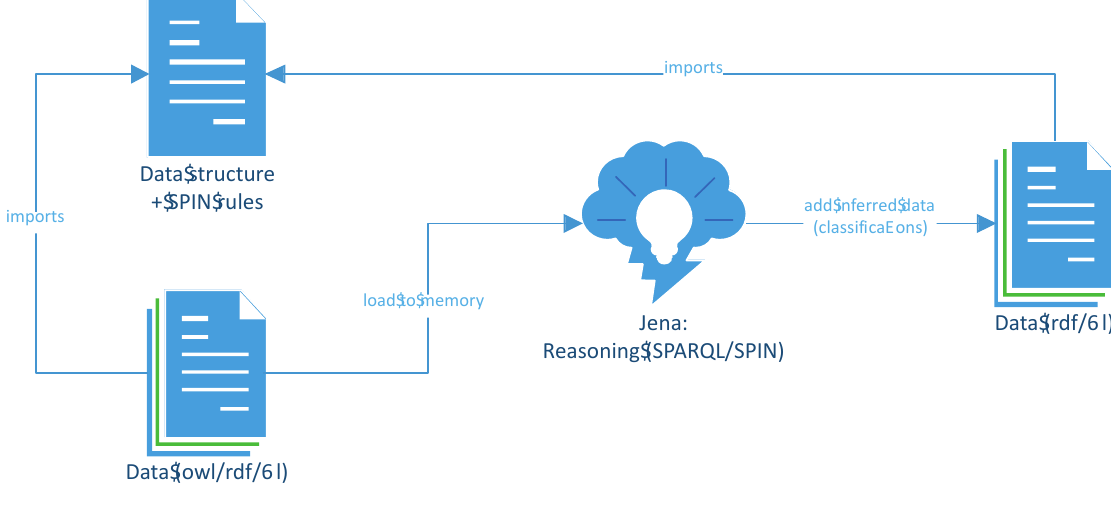
Figure 8. Workflow of the proposed RDF/SPARQL-based